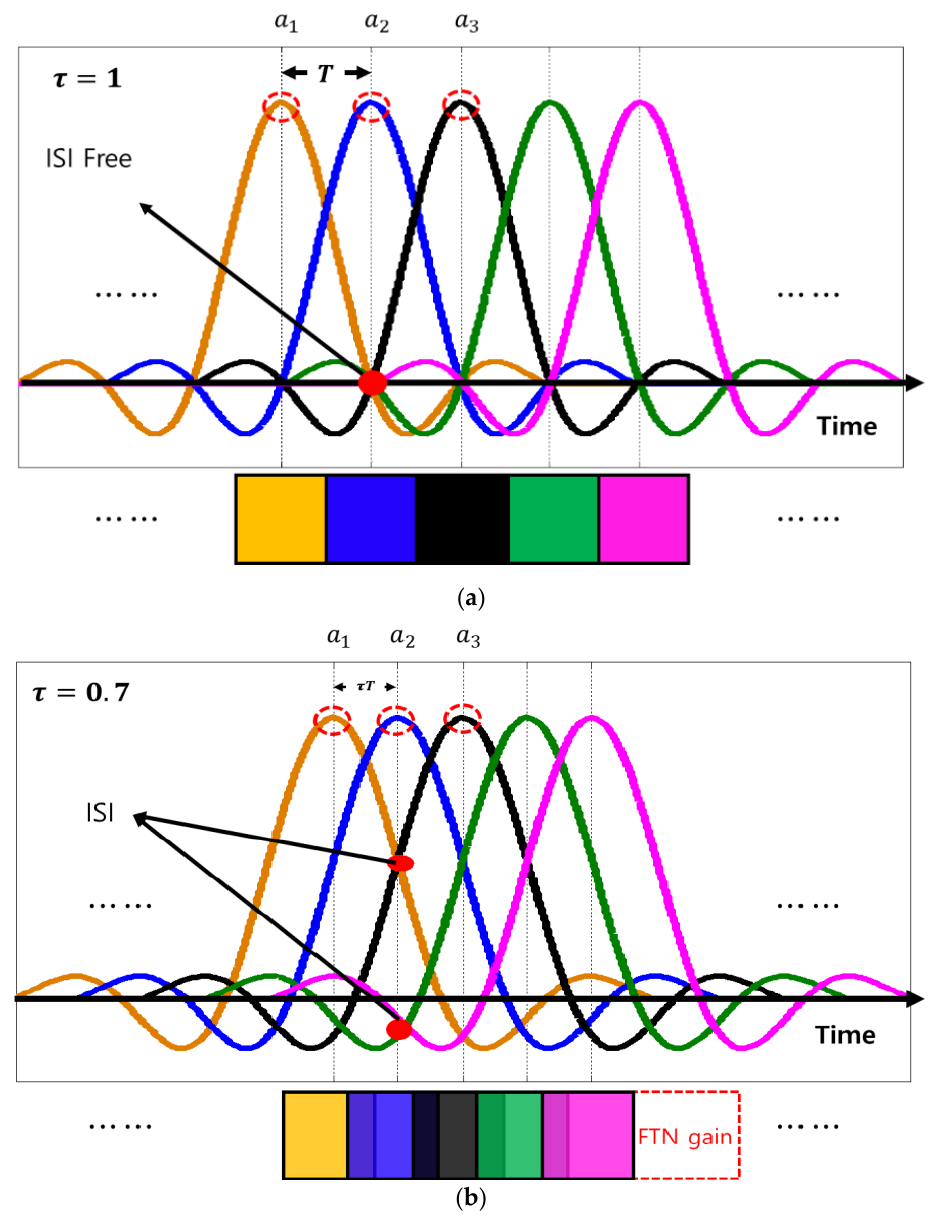
Figure 1. FTN signal (roll off factor = 0): ( a ) τ = 1 ; ( b ) τ = 0.7 .